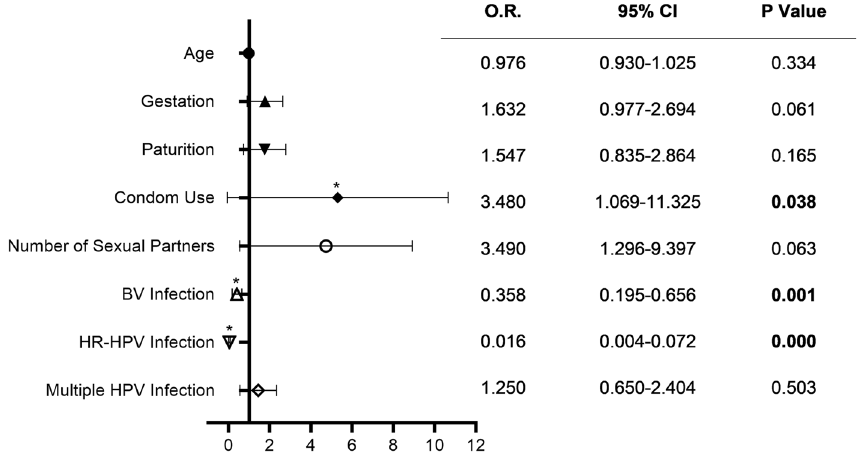
Figure 1. Odds ratio of possible risk factors for CIN Using Logistic regression. Bars represented 95% confidence intervals. O.R. : odds ratio, CI : confidence interval. * P <